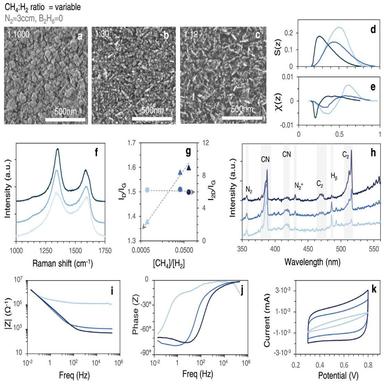
(a–c) SEM, (d,e) MFs, (f) Raman spectra with relative deconvoluted (g) peak ratios, (h) optical emission spectra of the C/N/H plasma, (i,j) EIS Bode plot and (k) voltammograms of three samples grown at a variable CH4/H2 ratio.